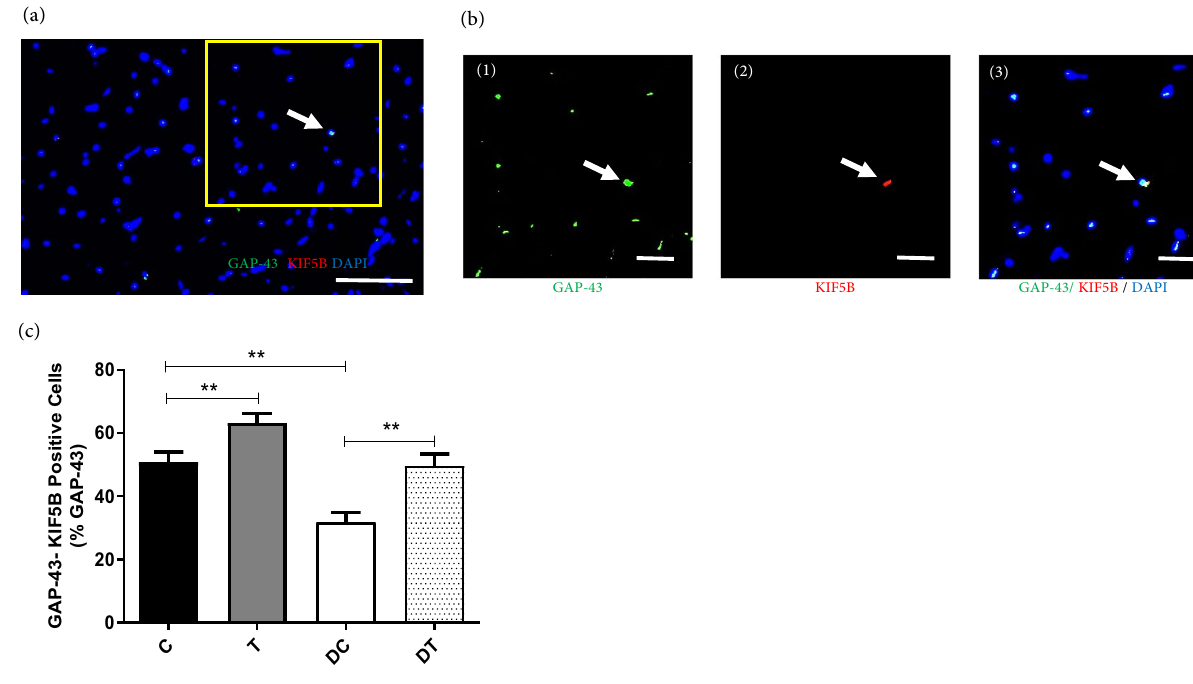
Figure 3. Double-immunostained labeling of KIF5B and GAP43 protein expression in the rat gastrocnemius muscle. ( a ) Representative image of KIF5B and GAP43 co-localization analysis showing GAP-43 (green), KIF5B (red) and myonuclei (blue). ( b 1–3) Higher magnification of selected area (yellow box) in image ( a ). ( c ) GAP-43-KIF5B positive Cells (% GAP-43 + ) in different experimental groups. White bar = 50 µm. ** p <